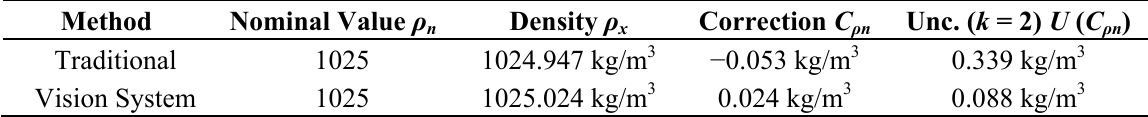
Table 9. Calibration results of the medium accuracy